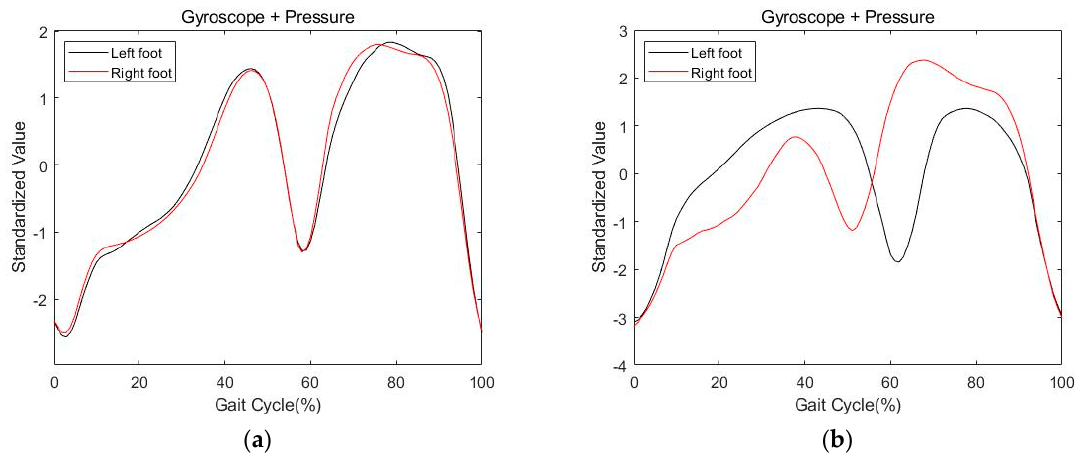
Figure 11. The results of combined data. ( a ) Symmetric gait; ( b ) asymmetric gait. Also, the DTW result graph and DTW distance for the combined data are shown in Figure 12. As the DTW distance becomes smaller, the two sequences can be regarded as similar, and the DTW distance of two completely identical sequences has a value of 0.